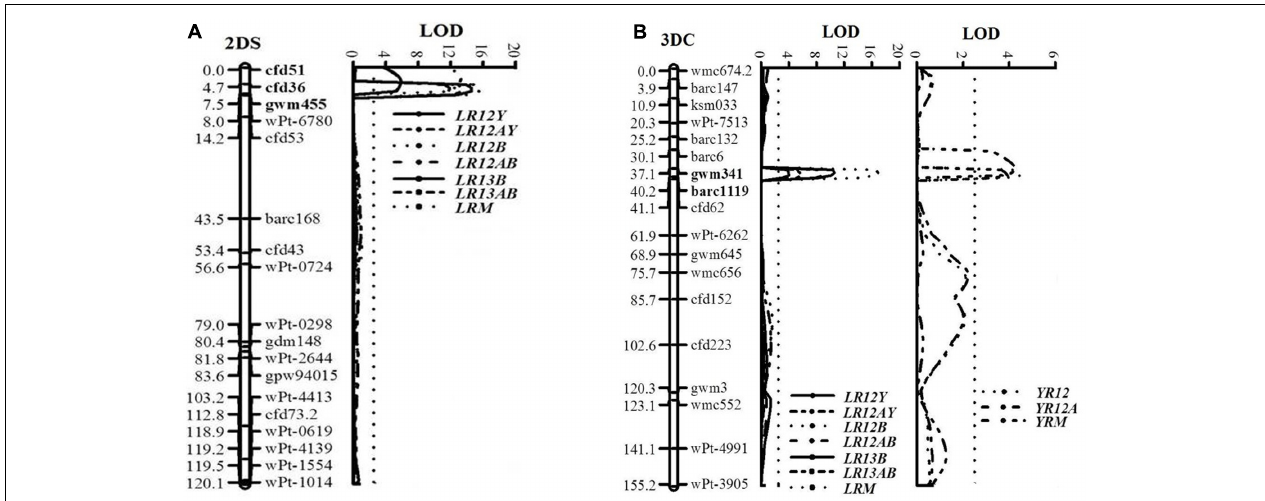
FIGURE 5 | LOD plots of quantitative trait loci (QTL) for adult plant resistance to leaf rust on chromosomes 2DS (A) and to both leaf and stripe rust on chromosome 3DC (B) , identified using IciMapping 4.1 in the UC1110/PI610750 RIL population. Significant LOD were detected based on 1,000 permutations. Positions (cM) of the molecular markers on chromosomes are shown on the vertical axes; cumulative genetic distances of linkage groups are also shown. LR12Y, LR12B, and LR13B: leaf rust phenotypic data at Ciudad Obregón in 2012 and El Batán during 2012 and 2013, respectively; YR12: stripe rust phenotypic data at Toluca in 2012; LR12AY, LR12AB, LR13AB, and YR12A: area under the disease progress curve (AUDPC); LRM and YRM: mean final disease severity over test environments. QTL flanking markers are in bold.